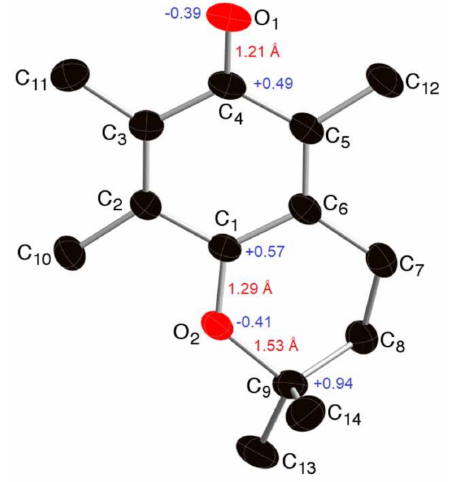
Figure 6. ORTEP plot for the molecular structure of (CH 3 ) α –TO + (crystallized with the [B(C 6 F 5 ) 4 ] − counteranion) with bond lengths in given in red [57]. Thermal ellipsoids are drawn at the 50% probability level and hydrogen atoms are omitted. HF/6–31 + G* potential-derived electrostatic charges from DFT calculations are given in blue